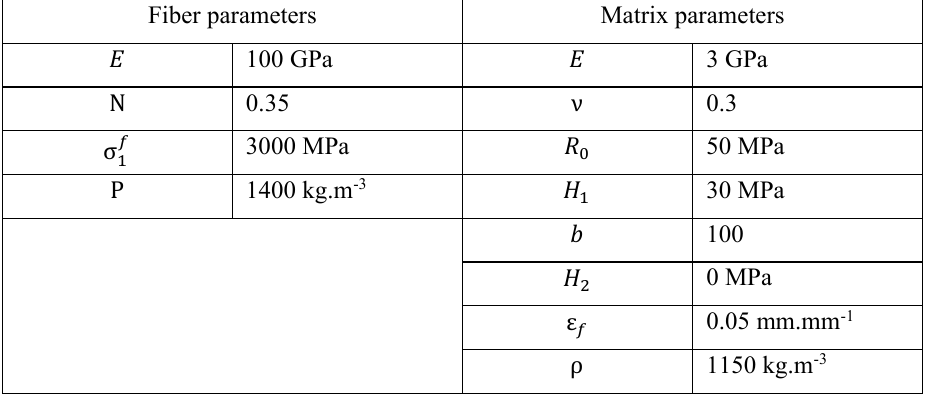
Table 1 : Material parameters used for the numerical examples (cf [20],